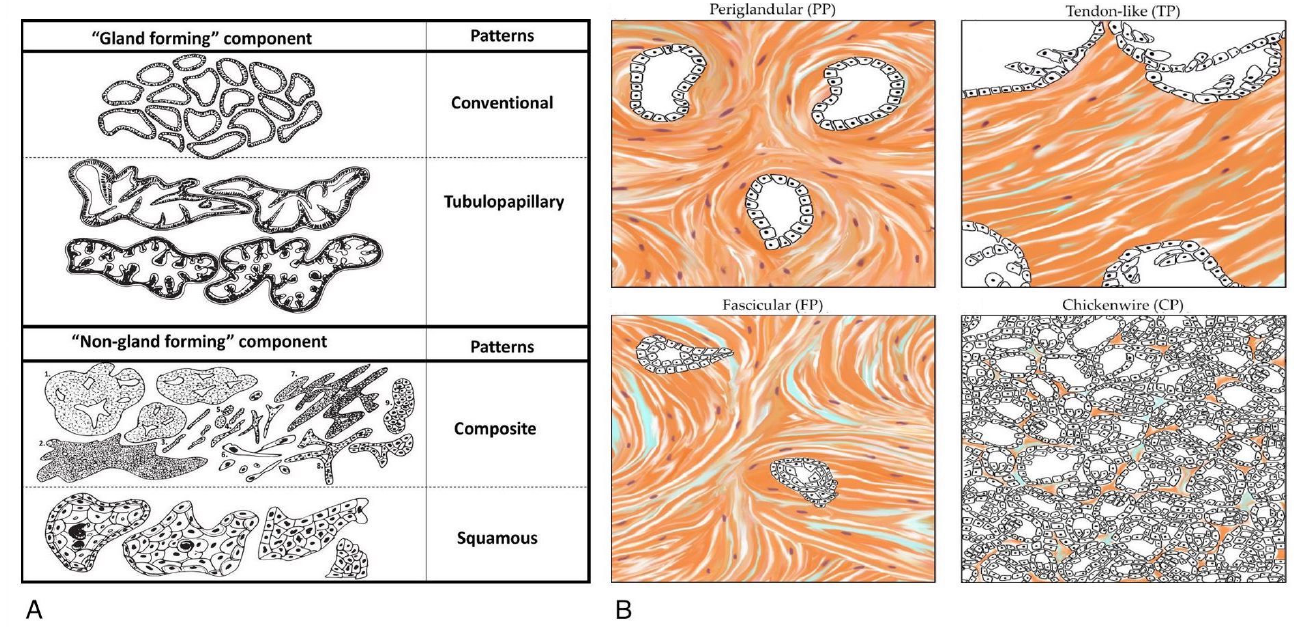
Figure 3. Morphological classifications: ( A )—proposed by Kalimuthu et al. [17], and ( B )—proposed by Sántha et al. [18]. See the text (Section 6) for further details on the topic. Images are reproduced with permission from Kalimuthu et al., Gut, published by BMJ, 2020 [17] and from Sántha et al., Cancers, published by MDPI, 2021 [18].